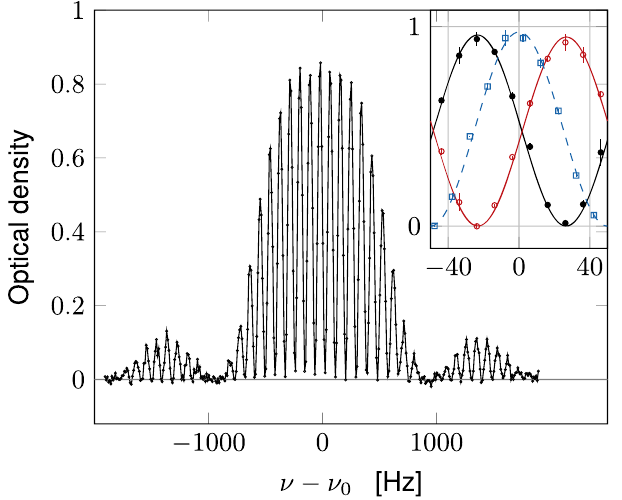
Fig. 1 Ramsey signal. Example of an interferometric Ramsey signal showing the optical density of the fraction of the gas in state 2 j i after the second Ramsey pulse, as a function of the microwave frequency ν . These data were recorded for (cid:2) n (cid:2) 40 atoms/ μ m 2 and T ~ 22 nK, τ 1 = 10 ms. Here, τ 2 has been increased to 1 ms to limit the number of fringes for better visibility. Inset. Filled black disks (resp. open red circles): central fringe for atoms in 2 j i (resp. 1 j i ) in our standard con fi guration τ 2 = 0.1 ms. The density in 1 j i is obtained by applying a microwave π -pulse just before the absorption imaging phase. When atoms are maximally transferred in state 2 j i , we observe no signi fi cant population in state 1 j i , compatible with a full transfer induced by the Ramsey pulses. Blue squares: single-atom response measured during the ballistic expansion of the cloud by imaging atoms in 2 j i . The lines in the inset are sinusoidal fi ts to the data. The vertical error bars of the inset correspond to the standard deviation of the three repetitions made for this measurement.